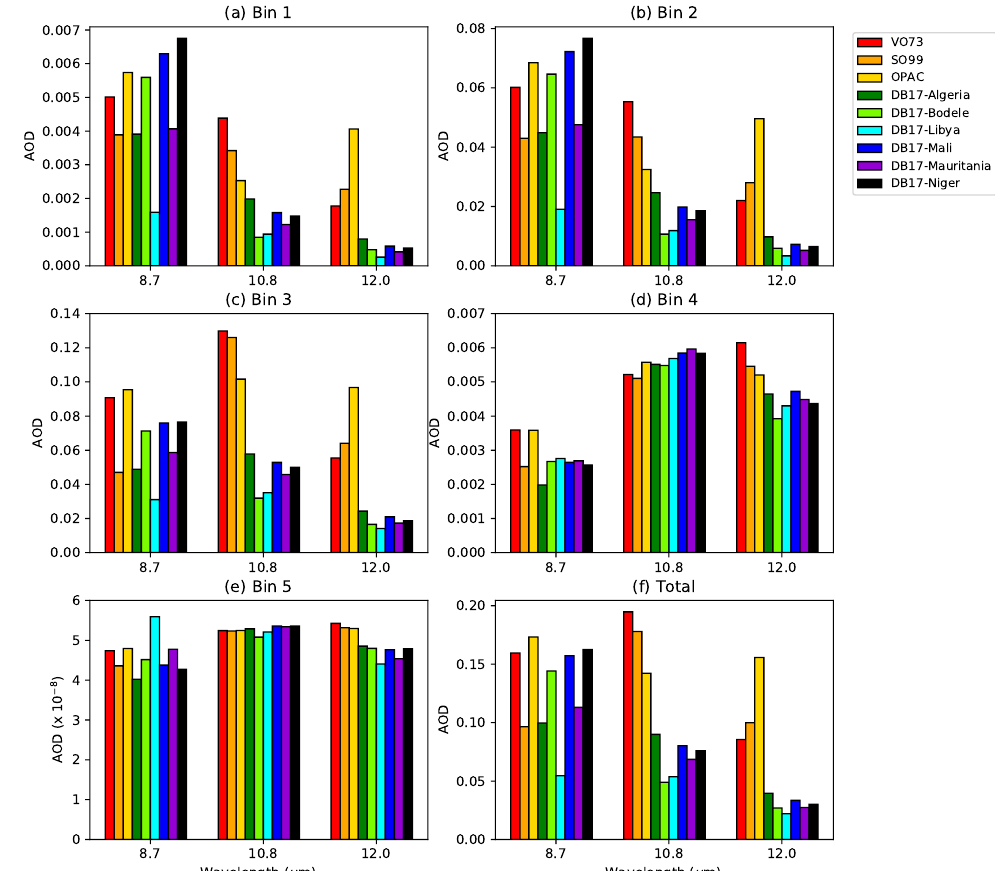
Figure 5. Plots of atmospheric column-integrated IR AODs for the five size bins and their total, over the BBM site in southern Algeria (21.38 ◦ N, 0.92 ◦ E), averaged for 09:00, 12:00, and 15:00UTC for June and July 2013, for MSG-3, and for each set of IR refractive indices considered in this study. Note that each panel has a different y -axis scale, and note also that each panel is multiplied by one temporally averaged value of the column-integrated number density, so the pattern of AOD within each panel is identical to the pattern of the extinction cross-section for that panel (i.e. for any panel the value of the correlation of the extinction cross-section and the AOD is 1). The particles are